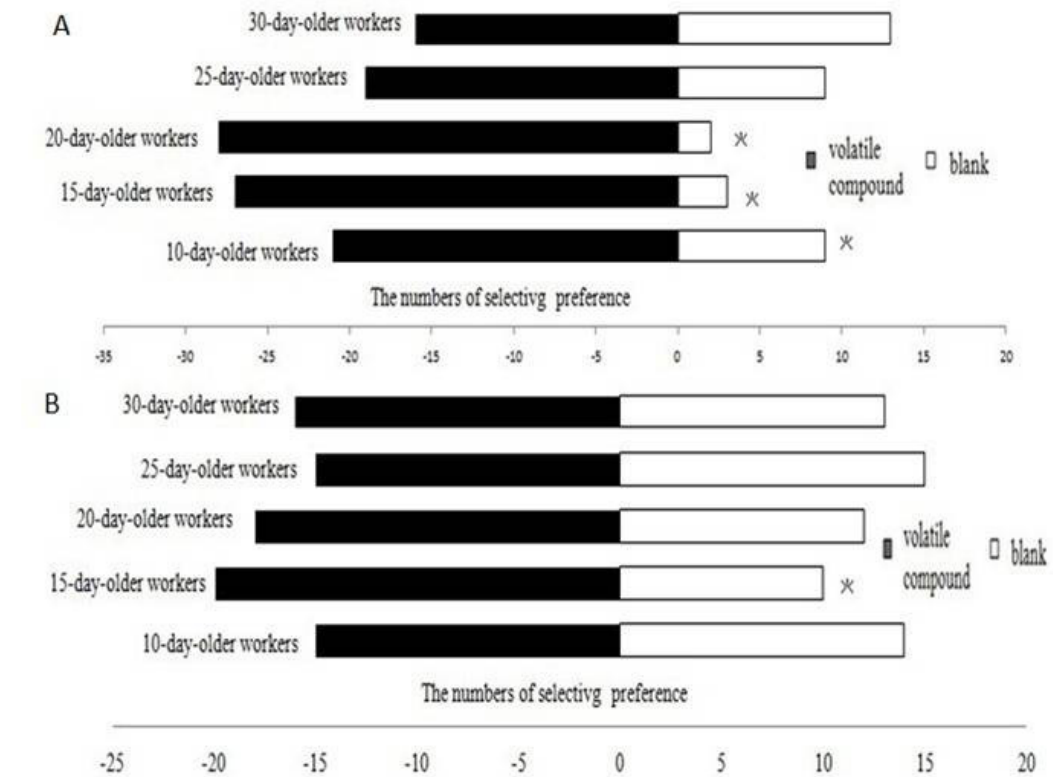
Fig 4 . Olfactory responses of honey bees, Apis mellifera ,to odors from the characteristic volatile compounds and a blank. A: Olfactory responses of different ages of workers in the healthy colony. B: Olfactory responses of different ages of workers in the diseased colony. Note: * indicated significant different, Significant at α=0.05,